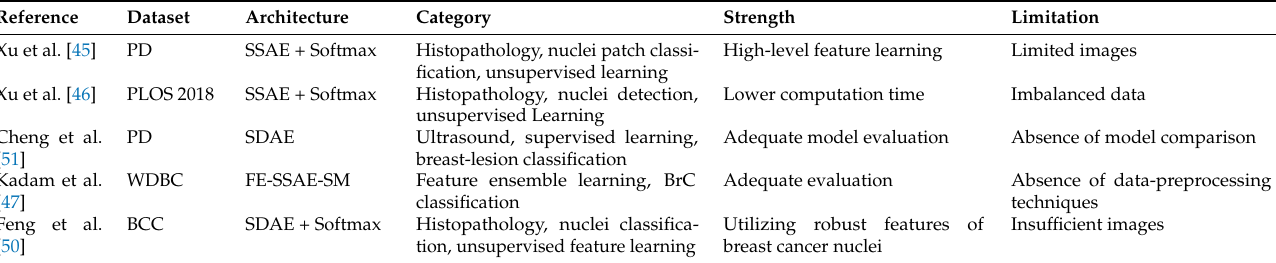
Table 3. State-of-the-art studies based on autoencoder